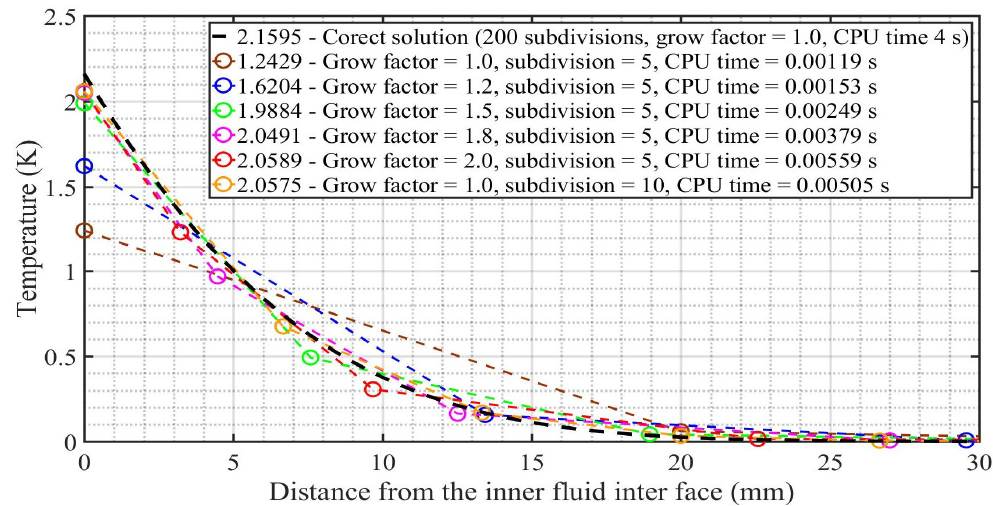
Figure 7. Demonstration of the solution quality (in the radial model) at 10 s for different subdivisions (Case 1).